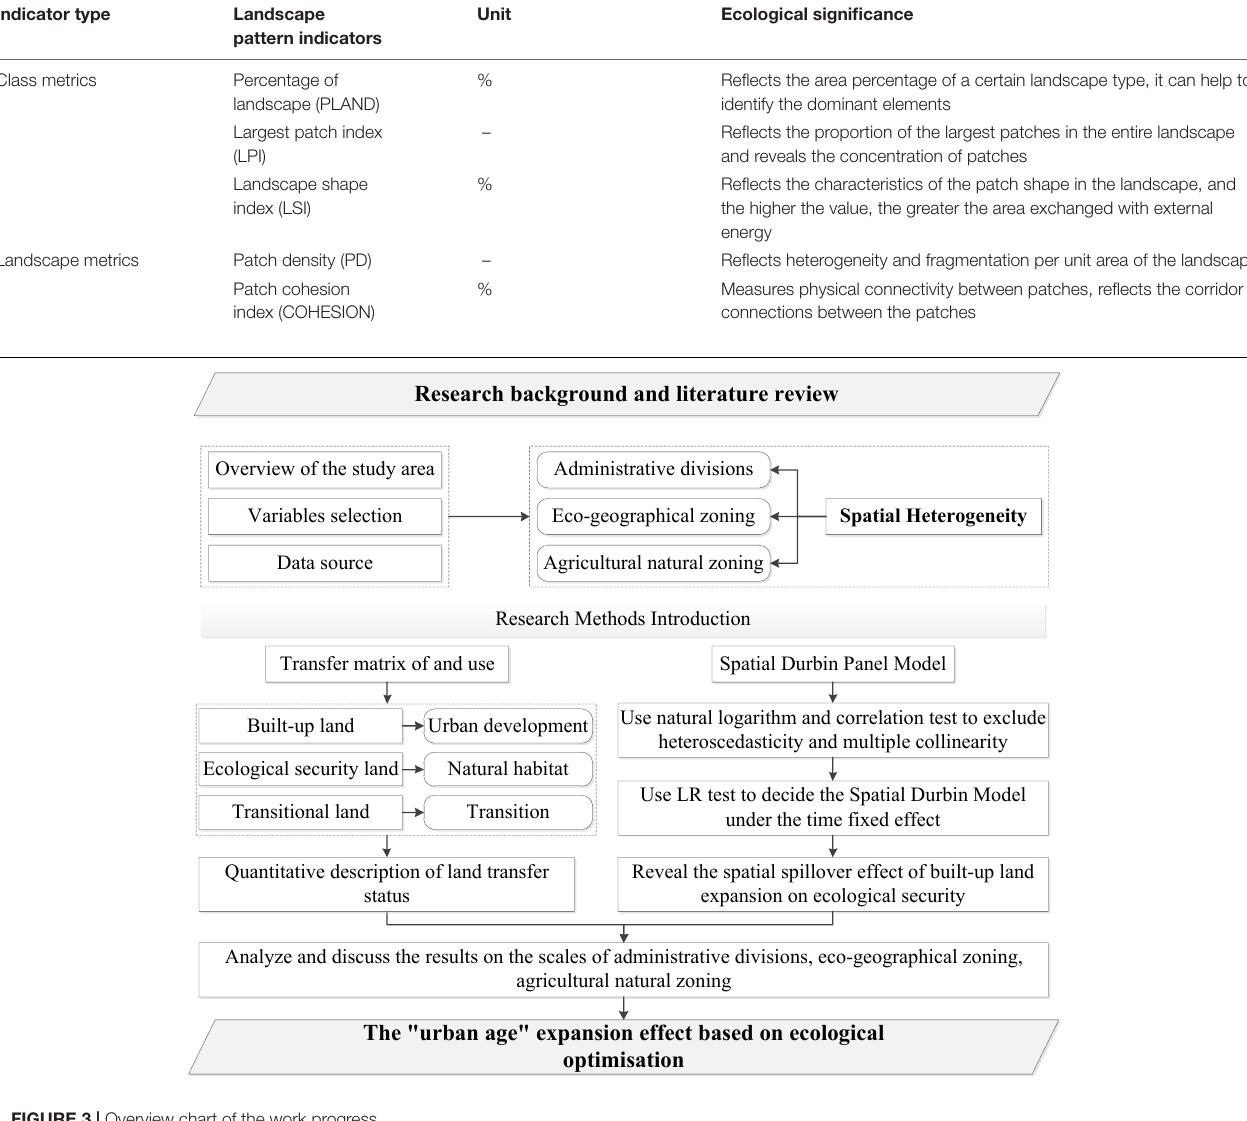
TABLE 1 | Description and significance of landscape pattern indicators.